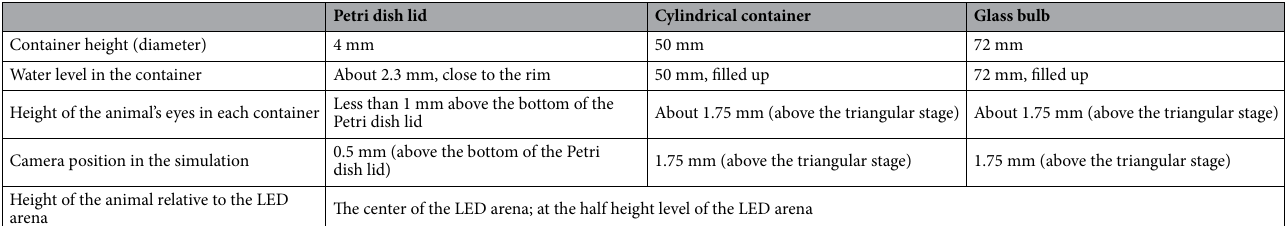
Table 1. Dimensions and observer positions for the three containers.